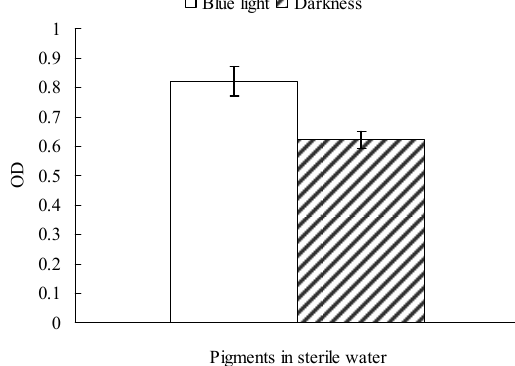
Figure 3. Effect of blue light on resting cell permeability of Monascus. Six resting pellicles (with the same pigment production) were respectively spread on six culture dishes containing 10 mL sterile water. Three pellicles were irradiated with blue light (0.16 mW/cm 2 ) for 8 h while the others were kept in darkness. The absorbance at 510 nm of the distilled water was determined after 8 h.